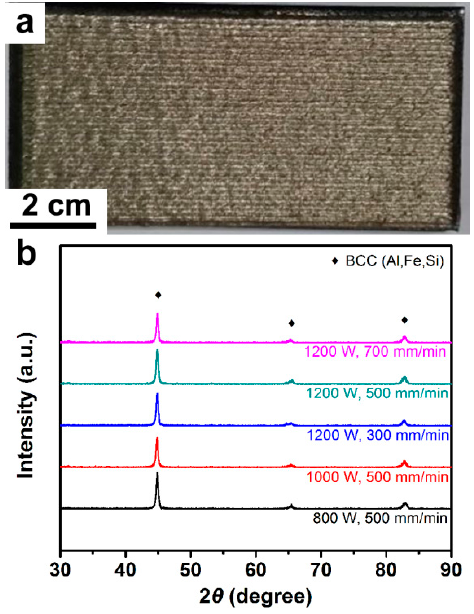
Figure 3. ( a ) Photograph of the Fe–Si–Al coating specimen 1 and ( b ) XRD spectra of the Fe–Si–Al-coat